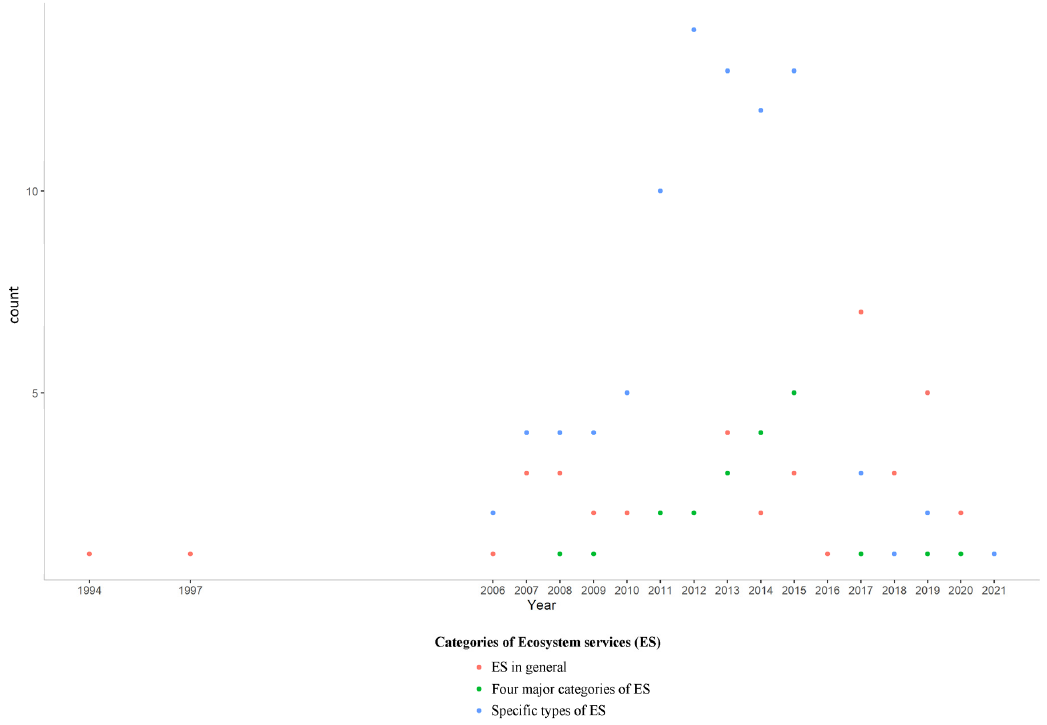
Figure 1. Categories of ecosystem services addressed in the analyzed papers.